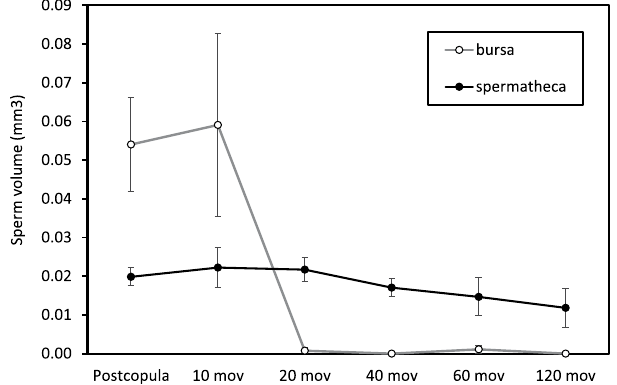
Figure 3. Sperm removal by male C. splendens in intraspecific matings. The volume of sperm stored in females preserved immediately after copulation (postcopula) is compared to the volume stored in double mated females, whose second mating was interrupted after a variable number of movements of the male genitalia during the stage I of copulation. Note that bursal sperm is completely removed after 20 movements. The volume of sperm in the spermatheca is negatively related to the number of stage I movements, but there are no significant differences among groups. Sample size is 8 for postcopula females and 5 for the other treatments.